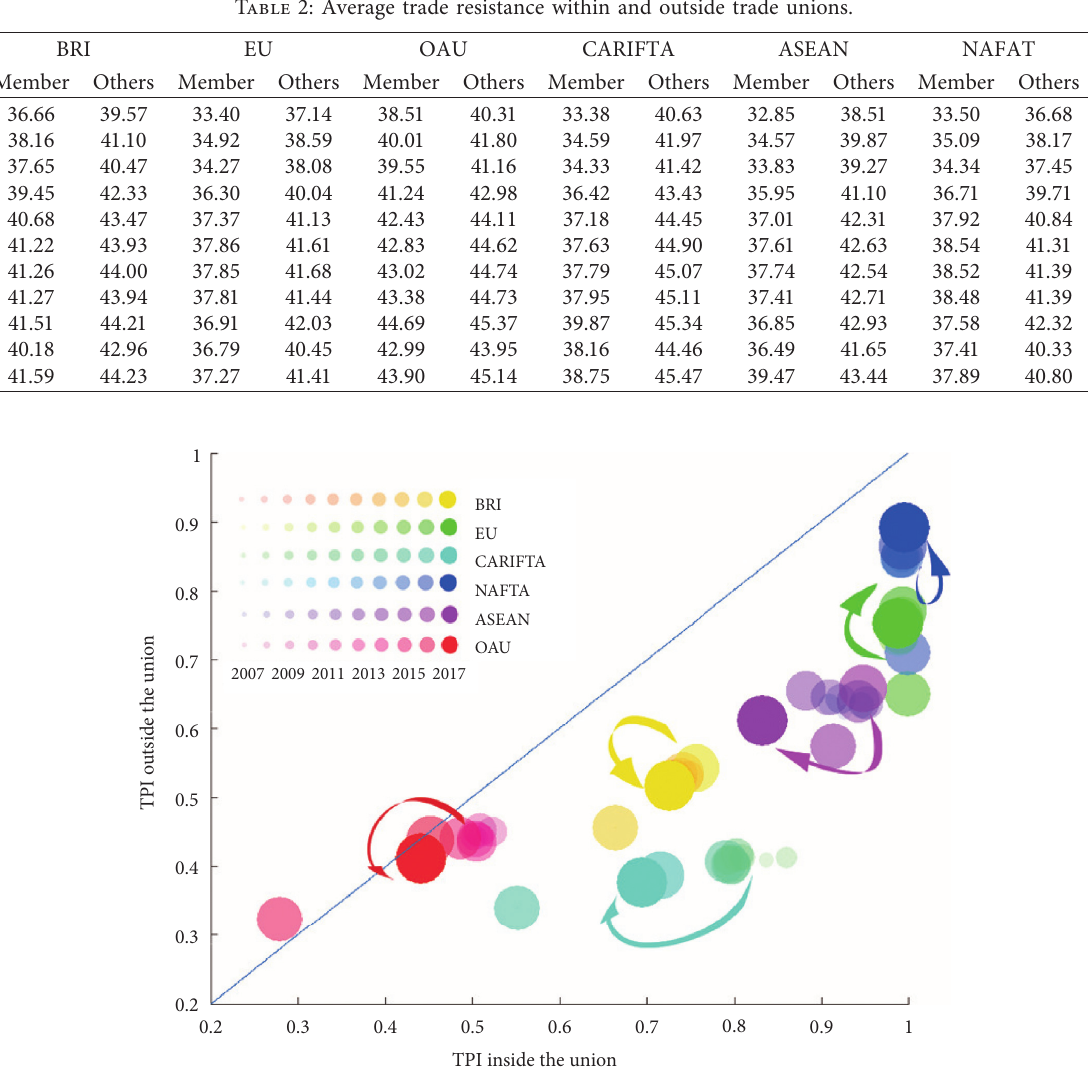
Figure 4: Trade purity indicator within and outside unions during the period 2007–2017. The x -coordinate expresses the TPI inside the union, and the y -coordinate expresses the TPI outside the union. The lightest color refers to year 2007, while the darkest color refers to year 2017. Table 3: The modularity of community classification based on Louvain